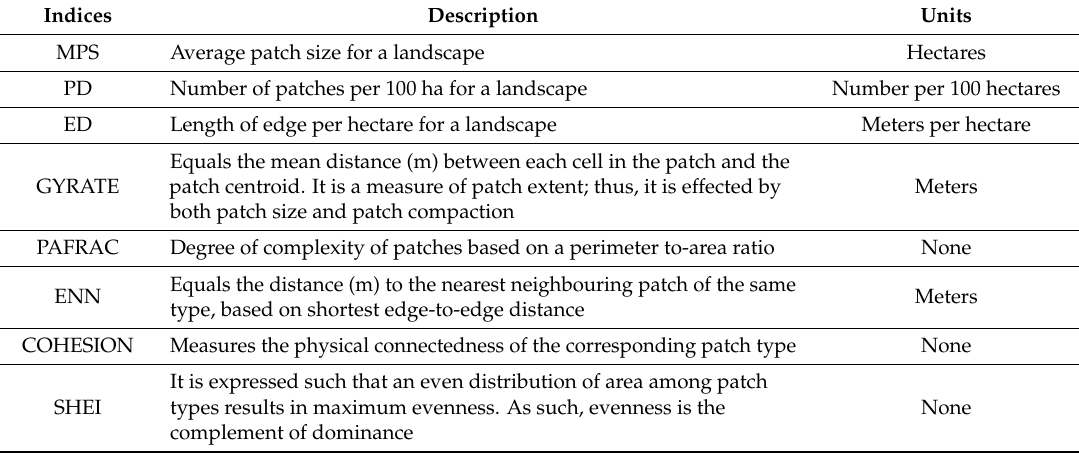
Table 2. Landscape metrics. MPS, mean patch size, PD, patch density, ED, edge density, GYRATE, radius of gyration, PAFRAC, perimeter-area fractal dimension, ENN, Euclidean Nearest-Neighbour Distanc, COHESION, patch cohesion index, SHEI, Shannon’s evenness index. Description